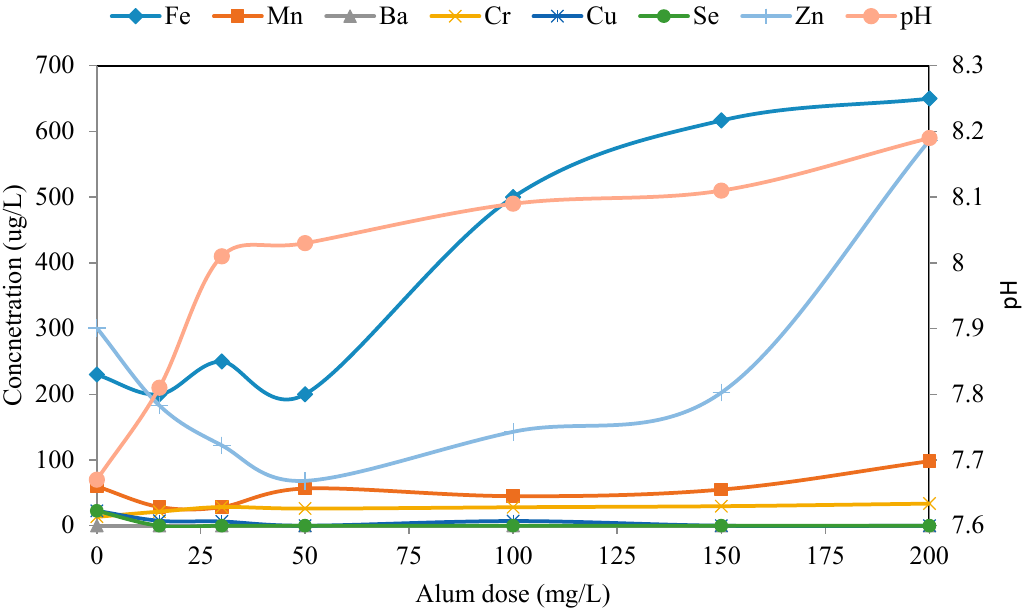
Figure 3. Residual concentrations of heavy metals at different alum doses (Jar test). pH= 7.7–8.2; temperature = 250 °C.